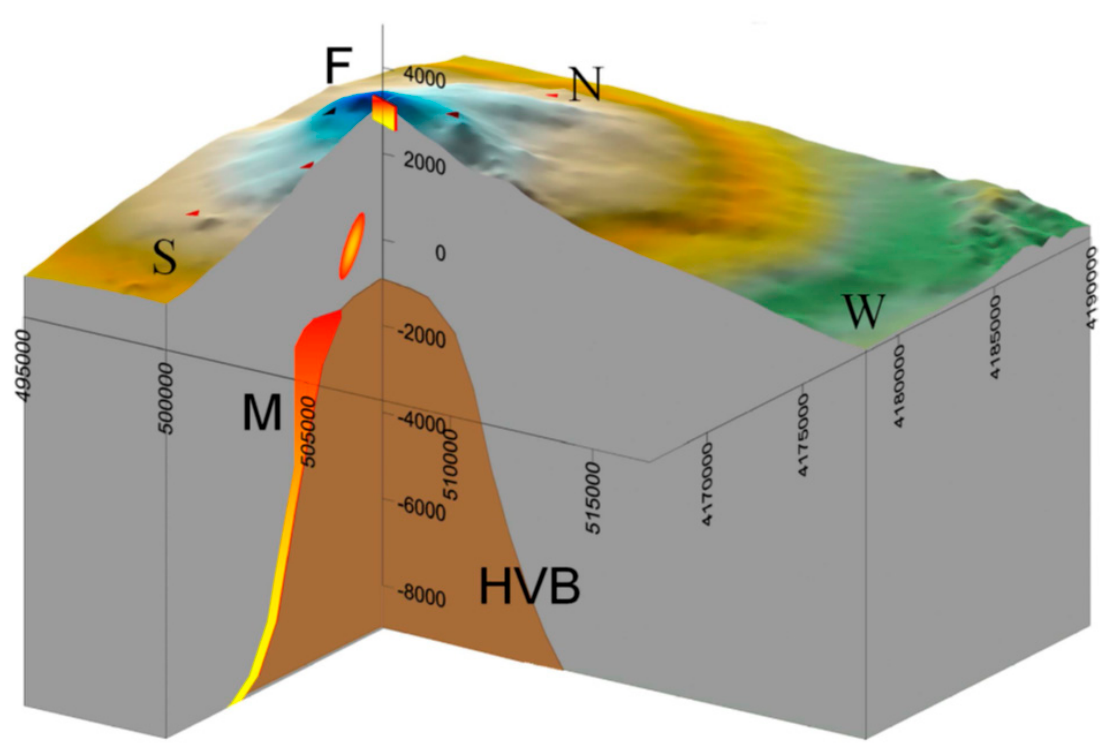
Figure 20. Graphic summary of the sources modeled in the studied 2008 Mt. Etna eruption. HVB : High velocity body, F : the dyke as modelled by the present study and previous works [102], M : main source body for the inflation phase preceding the eruption. UTM coordinates and depth are expressed in meters. The azimuth view is 40 ◦